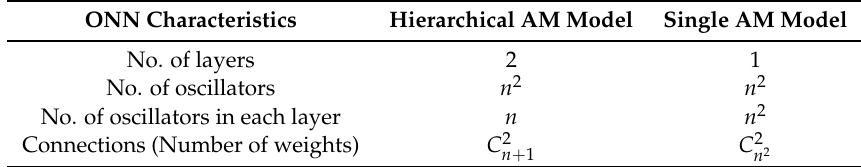
Table 2. Comparison of the proposed hierarchical AM model with the single AM model.